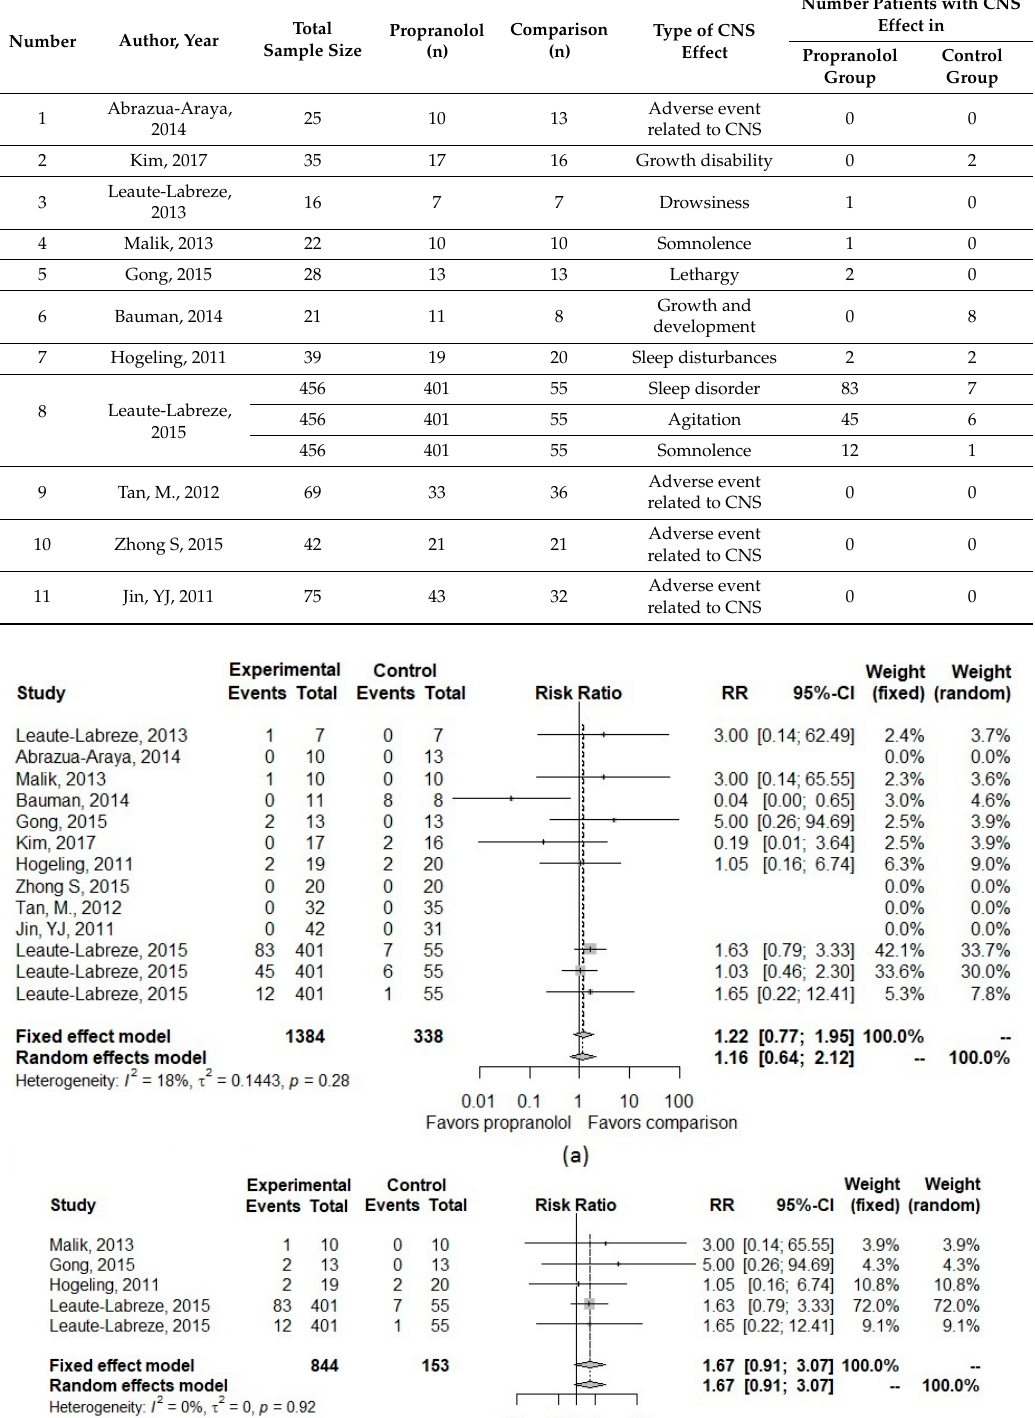
Table 2. Types and number of CNS adverse effects for the included studies.